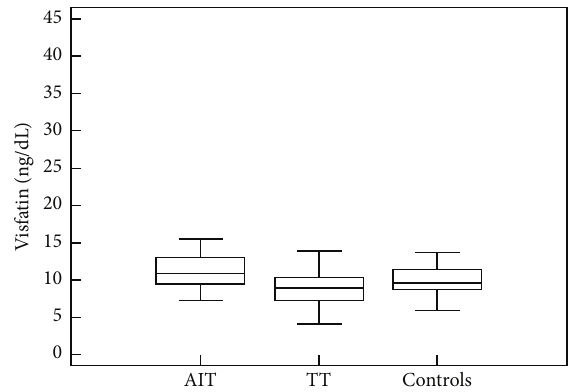
Figure 1: Comparison of visfatin serum concentration in hypothy- roid patients with chronic autoimmune thyroiditis (AIT), in hypothyroid patients after total thyroidectomy (TT), and in healthy controls (controls). Central box represents the values from the lower to upper quartile (25th to 75th percentile). The middle line represents the median. The thin vertical lines extending up or down from the boxes to horizontal lines (so-called whiskers) extend to a multiple of 1.5 × the distance of the upper and lower quartile,